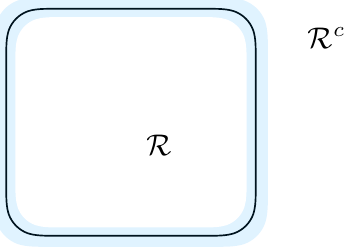
Figure 4 . In a system with exponential decay of correlations, one could intuitively expect the degrees of freedom in the bulk of region to have almost no entanglement with degrees of freedom R c . This would mean that only degrees of freedom in a neighbourhood of the boundary (shaded in R in blue in the picture) are signi(cid:12)cantly entangled, leading to an area law. to be correct in the context of spin chain (1+1 dimensional lattice systems with a